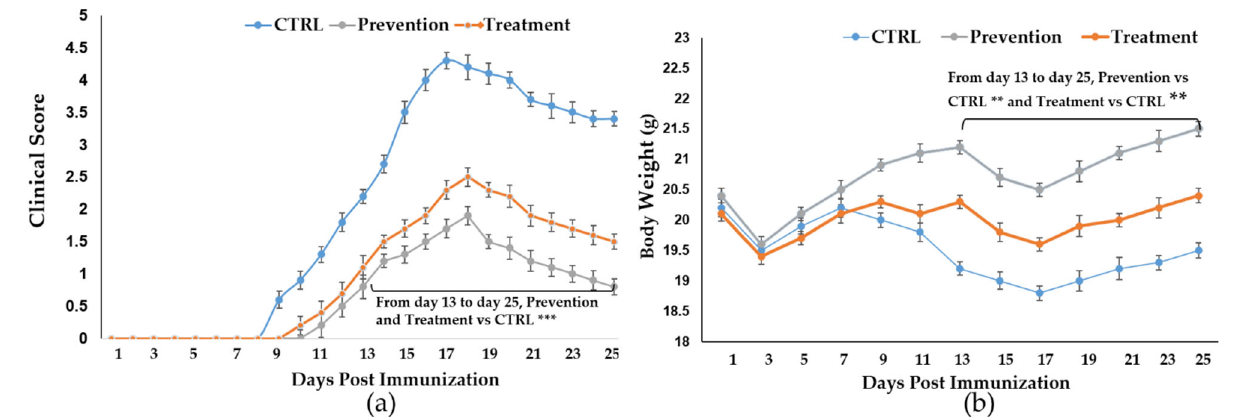
Figure 1. Oral administration of MOG inhibited the development of EAE in C57BL/6 mice. Preven ‐